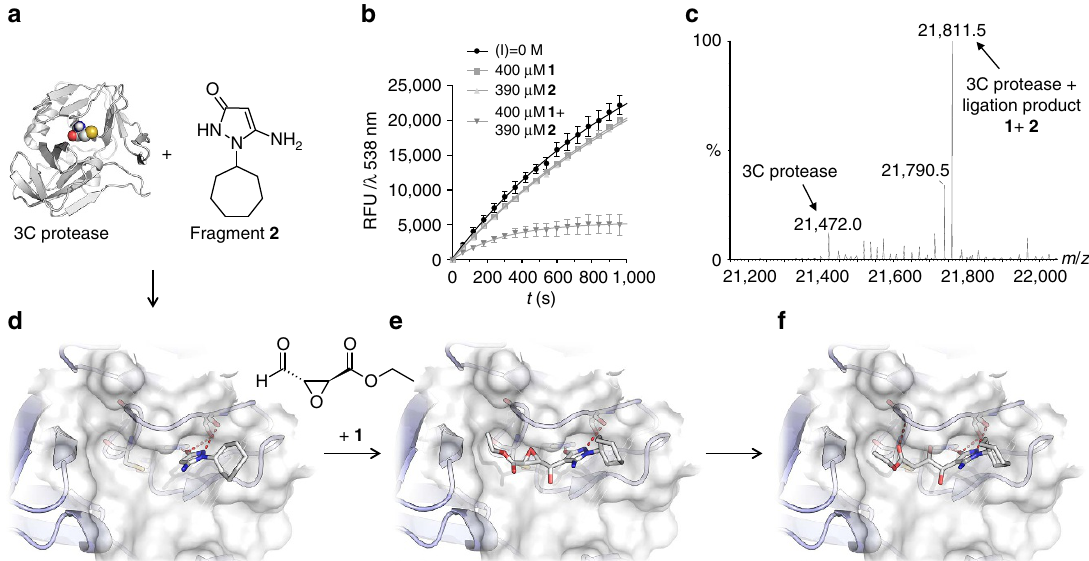
Figure 3 | Results of screening a fragment library using the warhead activation assay. ( a ) Molecular modelling of the reversible binding of fragment 2 to the S1 pocket of Coxsackie virus protease, the reversible ligation of warhead 1 , and the irreversible modification of Cys-147. The most important interactions are shown as red dotted lines. ( b ) Over-additive inhibition of Coxsackie virus protease by combination of warhead 1 and fragment 2 . 1 and 2 alone are virtually inactive. ( c ) Deconvoluted ESI-mass spectrum of the 3C protease after incubation with warhead 1 and fragment 2 . Main mass signal at 21,811.5Da corresponds to the mass of the protein complex þ 1 þ 2 . ( d – f ) Three-dimensional illustrations of fragment binding to the S1 pocket of CV3B 3C protease obtained by docking experiments. ( d ) Initial non-covalent binding of fragment. ( e ) Non-covalent binding of the fragment ligation product. ( f ) Covalent binding of ligation product after epoxide